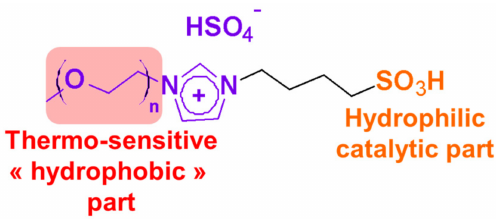
Figure 27. Thermosensitive amphiphilic Brønsted acid imidazolium salts used for the synthesis of